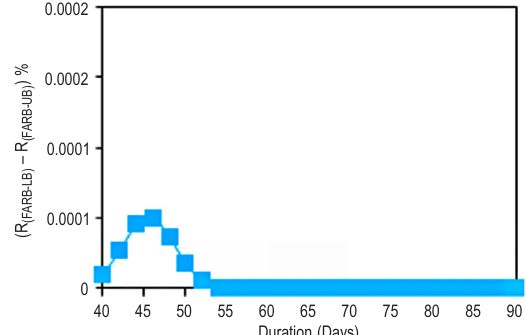
Fig. 5. Differences between upper and lower bounds of the reliability of project completion time with ρ 0 = 0.65